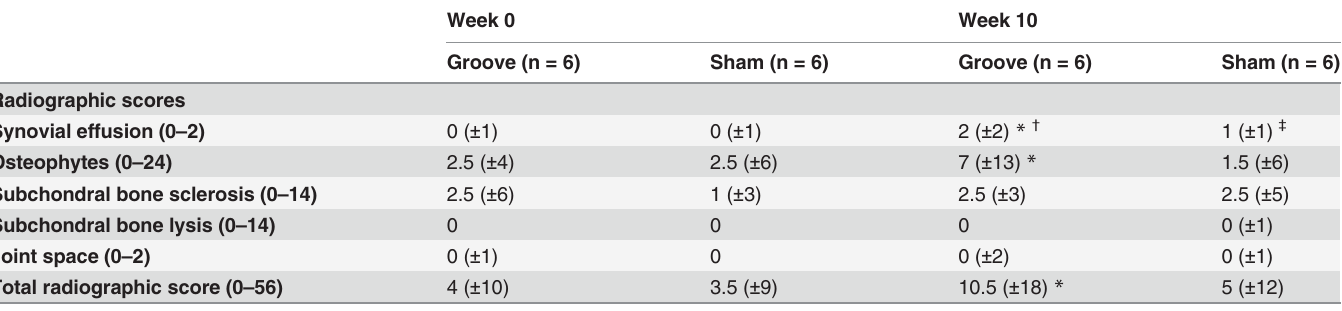
* Values represent signi fi cant differences between groove joints at weeks 0 and 10 ( P < 0.05). † Signi fi cant differences between groove joints and sham joints at week 10 ( P < 0.05) ‡ Signi fi cant differences between sham joints at weeks 0 and 10 ( P <